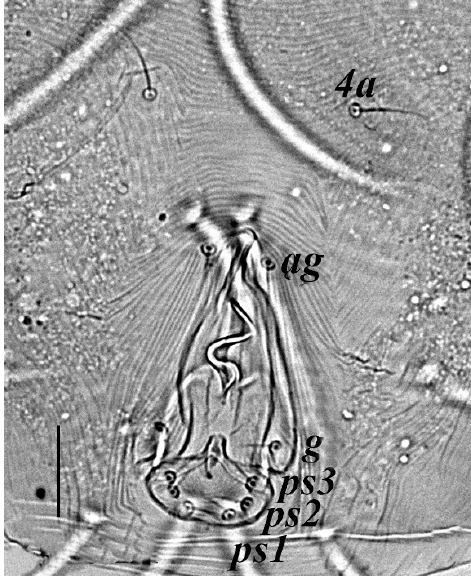
Figure 5. Neophyllobius combreticola . Female. Genital and anal region. Scale bar: 20 μ m.